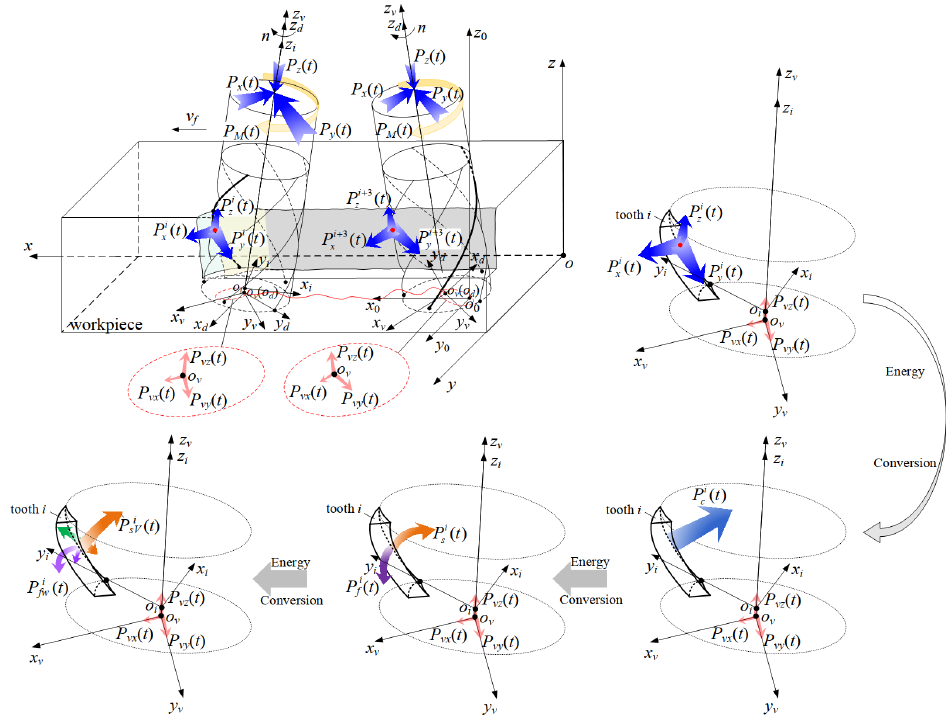
Figure 1. Instantaneous cutting posture and energy of milling cutter under vibration.